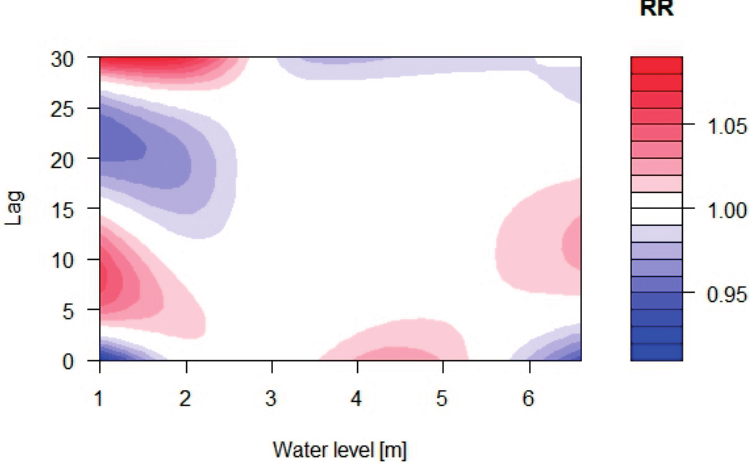
Figure 7. Contour plot of the relative risk (RR) of all-cause mortality along water level and lags, with reference to the median water level using a distributed lag non-linear model.